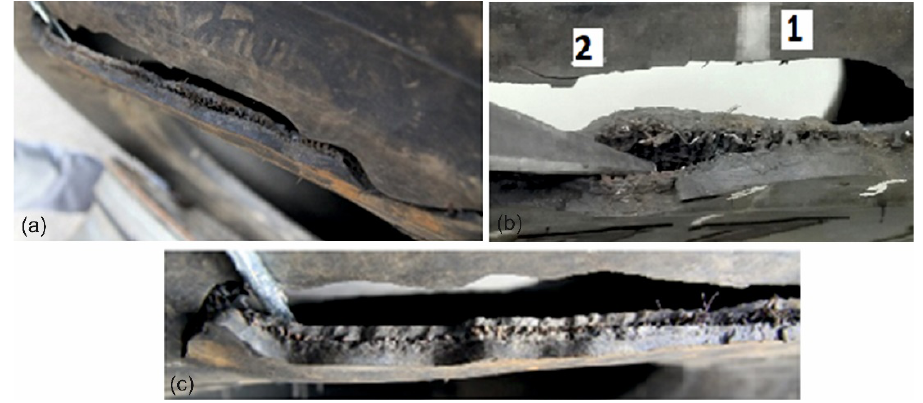
Figure 12. View of the crack in the sidewall of the tire.